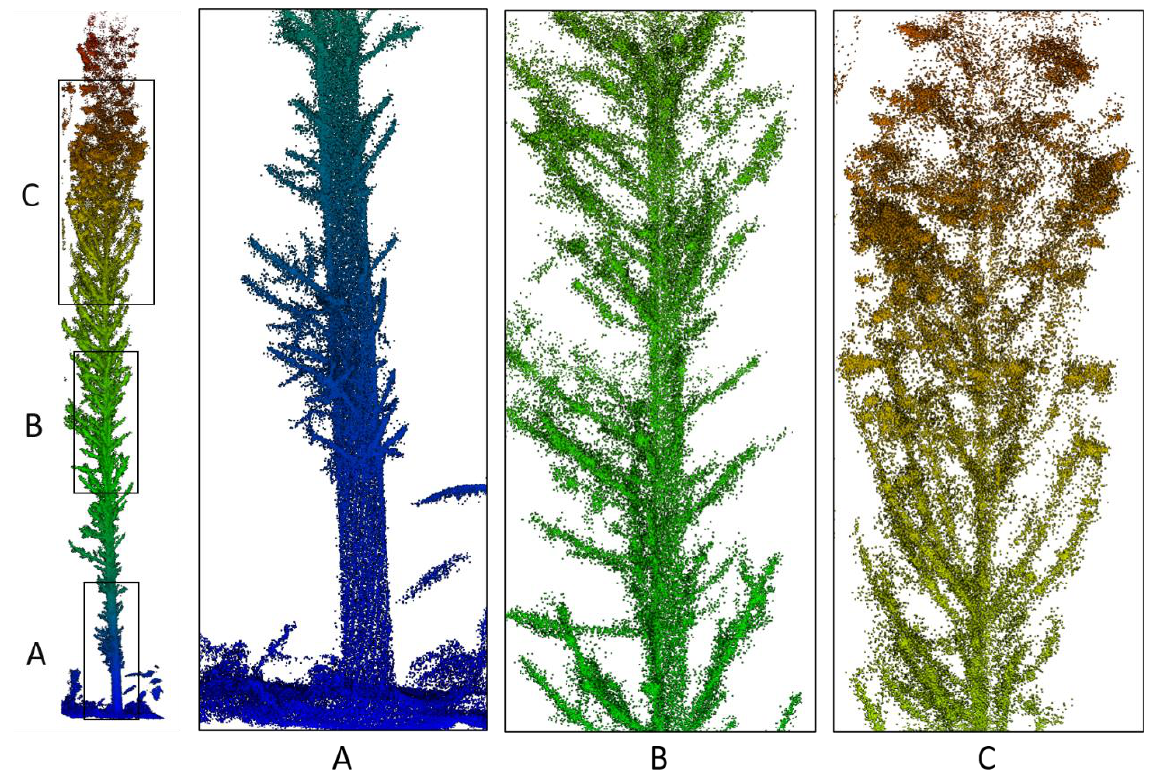
Figure 4. Above shows an example of the ambiguity resulting from a combination of error induced by beam divergence effects and increasing occlusion effects with height. ( A ) Shows a very clearly reconstructed stem. ( C ) Shows points from the canopy which would be labeled as vegetation class per our definitions. ( B ) Shows the ambiguous region in between ( A ) and ( C ), where stems are identifiable, but are in-between the stem ( A ) and vegetation ( C ) class definitions. Ambiguous regions as shown in ( B ) were removed from several of the training, testing and validation datasets as needed.